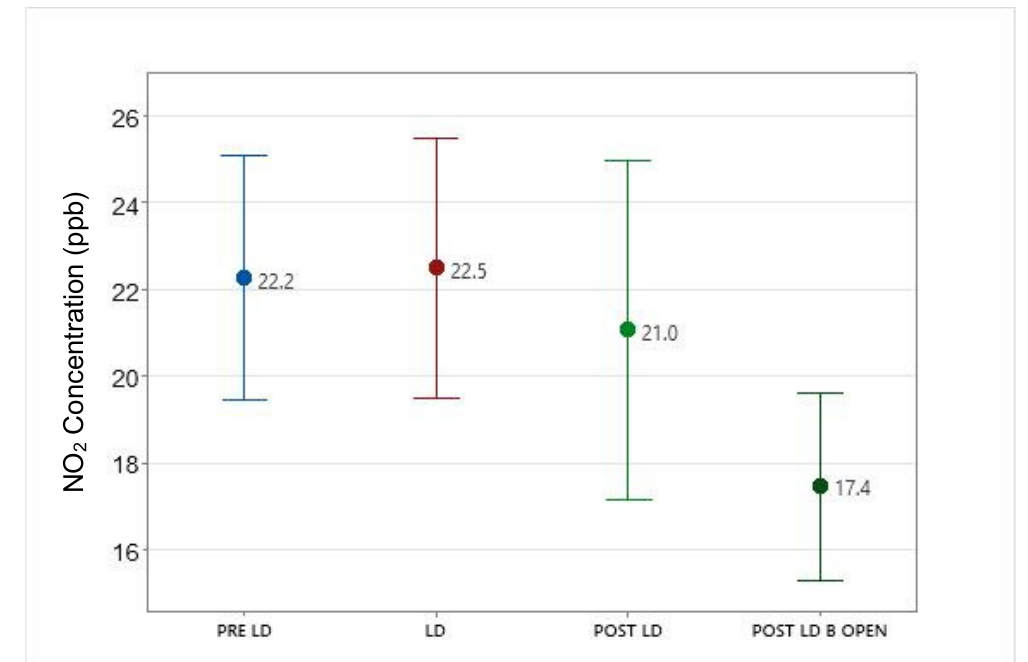
Figure 6. Change in mean PM 2.5 concentrations before, during, and after the lockdown period. Error bars represent 95% confidence interval of the mean. Abbreviations: PRE LD: Pre-lockdown, LD: Lockdown, POST LD: Post-lockdown and POST LD_B OPEN: Post-lockdown—businesses open.